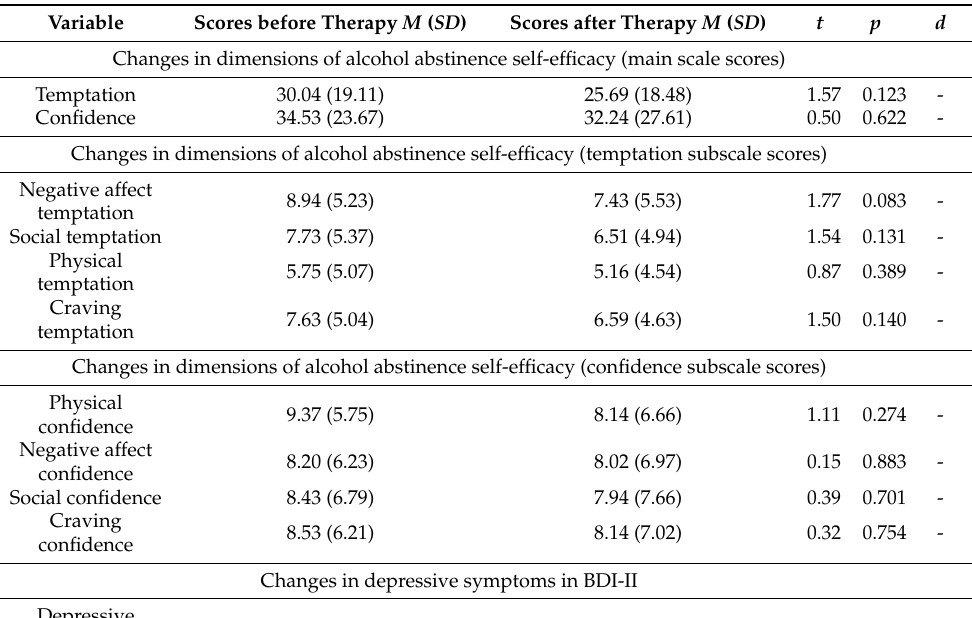
Table 2. Changes in dimensions of self-efficacy and depressive symptoms in the investigated group before and after